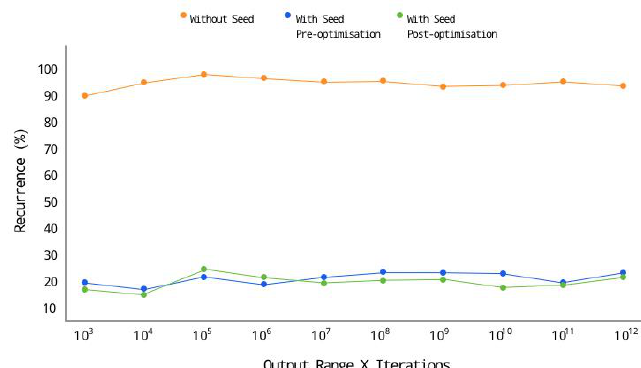
Fig. 26. Performance of three models high noise scenario I